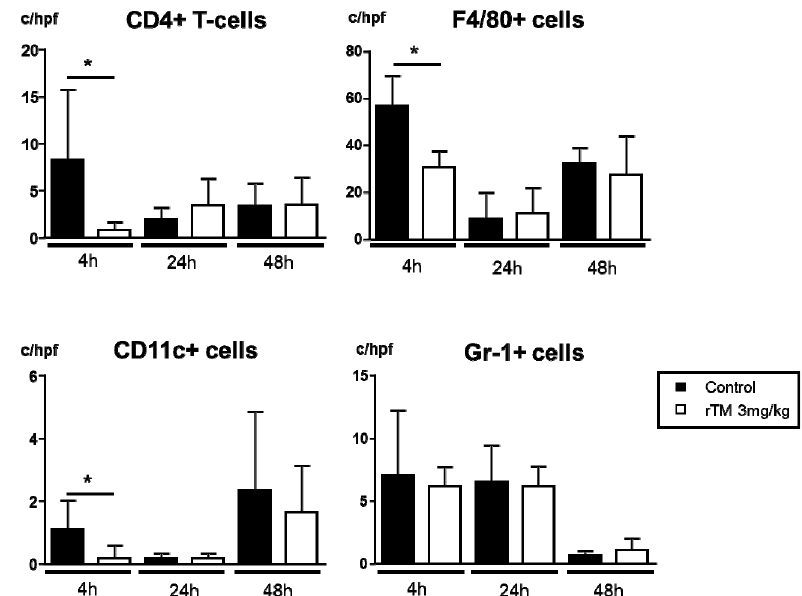
Figure 4. Effect of recombinant human soluble thrombomodulin (rTM) on the accumulation of inflammation cells in the interstitium after lipopolysaccharide (LPS) injection. The accumulation of CD4+ T-cells, and F4/80 + , CD11c+, and Gr-1+ cells in the interstitium at 0 (control and rTM, n = 3), 4 ( n = 7 and 6), 24 ( n = 4 and 5) and 48 h ( n = 5 and 6) before and after LPS-injection. The data are the mean ±standard error of the mean (* p < 0.05 , cell numbers in control versus rTM-treated mice).